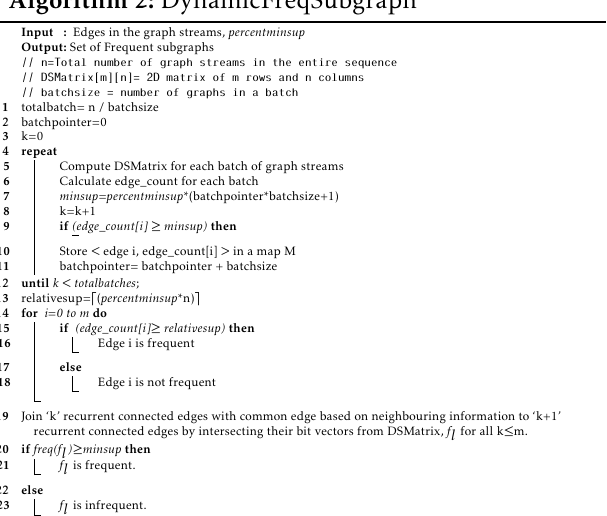
Table 6. Frequent Edges with count for Batch 1, Batch2